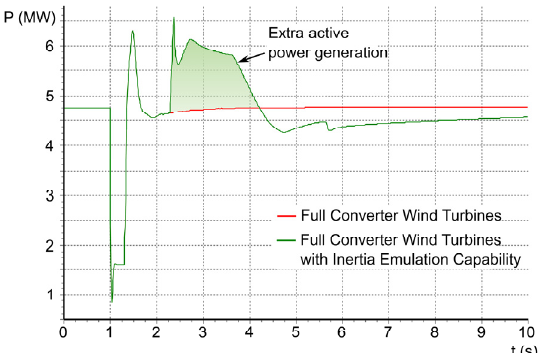
Figure 14. Active power generated by wind farm Number 2 for both the full converter wind turbine and the full converter with inertia emulation capability, for a 300-ms three-phase short circuit at the Las Salinas bus with 80 MW of total wind power